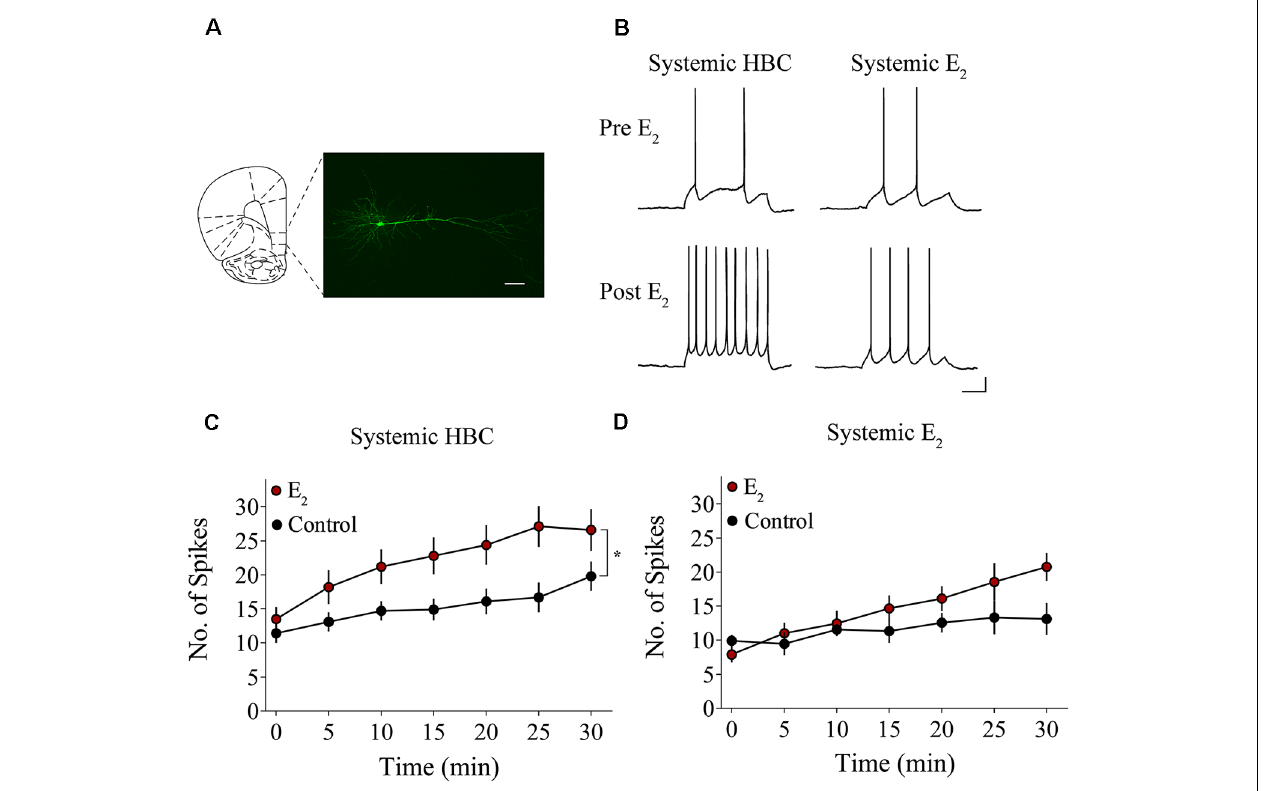
FIGURE 2 | Bath-application of E 2 potentiates IL-mPFC pyramidal neuron excitability. (A) Photomicrograph of a biocytin-filled IL-mPFC pyramidal neuron. Scale bar, 50 µ m. (B) Individual traces of current-evoked action potentials (APs) from IL-mPFC pyramidal neurons before (top) and after (bottom) bath-application of E 2 in slices from ovariectomized (OVX) female rats that were systemically injected with 2-hydroxypropyl- β -cyclodextrin (HBC)-vehicle (left) or with E 2 (right). Scale bars, 10 mV (vertical) and 500 ms (horizontal). (C) Compared to artificial cerebral spinal fluid (aCSF) alone ( n = 10), bath-application of E 2 ( n = 10) enhances intrinsic excitability in IL-mPFC neurons from OVX female rats that were systemically injected with HBC-vehicle prior to recordings. (D) Compared to aCSF alone ( n = 9), bath-application of E 2 ( n = 9) does not enhance intrinsic excitability in IL-mPFC neurons from OVX female rats that were systemically injected with E 2 prior to recordings. ∗ p < 0.05. Error bars indicate SEM.